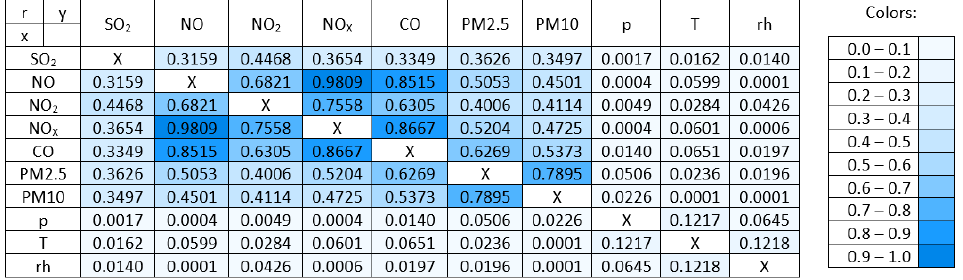
Figure 8. Correlation heat map with all obtained air pollution parameters from the sample. According to the correlation heat map, the high correlation (r values from 0.9 to 0.7) was computed with pairs NO-NO x (r = 0.9809), CO-NO x (r = 0.8667), NO-CO (r = 0.8515), PM2.5-PM10 (r = 0.7895), NO 2 -NO x (r = 0.7558), while for moderate correlation (r values from 0.7 to 0.5), there are also six air pollutant pairs. It could be concluded that the com- puted correlation between meteorological parameters and air pollutants is very low, with